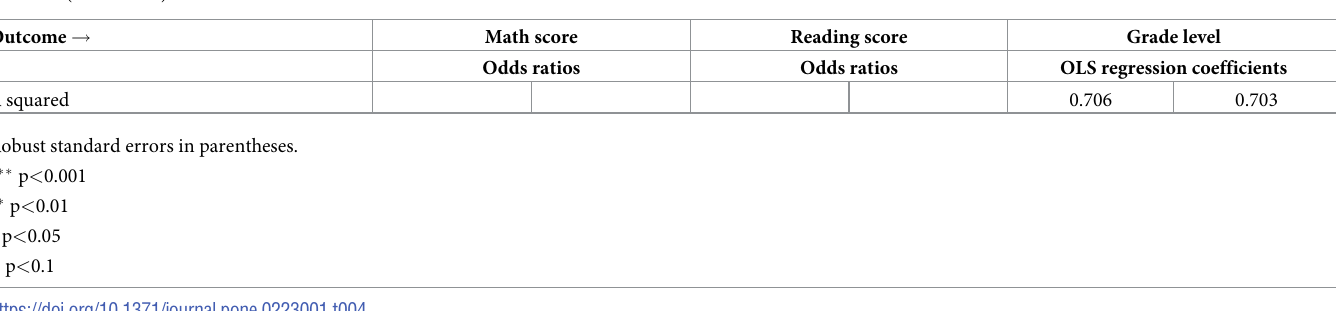
S1 Table. Bivariate regression results. Panel A. Bivariate regression models of the association between cognitive achievement and educational attainment and height-for-age z-scores and stunting. Panel B. Bivariate regression models of the association between cognitive achieve- ment and educational attainment and BMI-for-age z-scores and thinness. Panel C. Bivariate regression models of the association between cognitive achievement and educational attain- ment and weight-for-age z-scores and